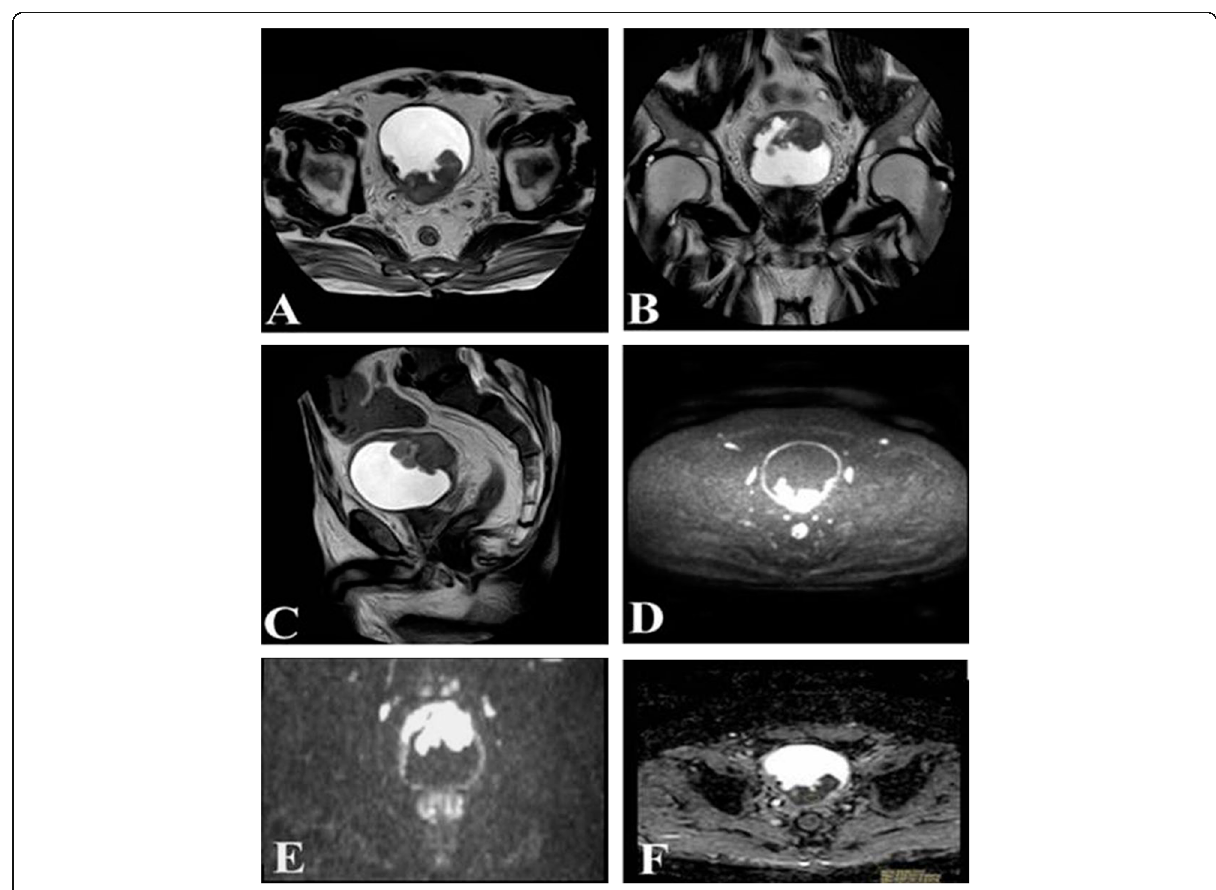
Fig. 4 A vesical soft tissue mass is seen arising from superior part of posterior wall with muscular invasion and presumably perivesical invasion on HR T2 images, yet it seems confined to the wall on DWI images. a Axial HR T2 image, b coronal HR T2 image, c sagittal HR T2 image, d axial DWI image (b 1400), e coronal DWI image (b 1400), and f axial ADC map with ADC measured within lesion (0.93 × 10 − 3 mm2/s).